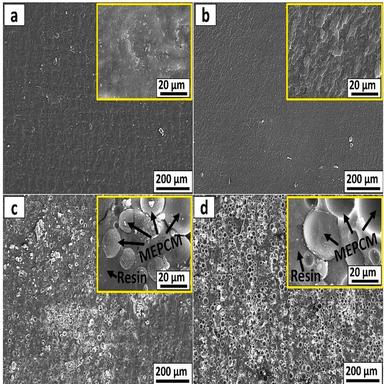
Surface (a, c) and cross-sectional (b, d) morphology of 3D-SLA/MEPCM-0 (a,b) and 3D-SLA/MEPCM-40 (c, d) samples.